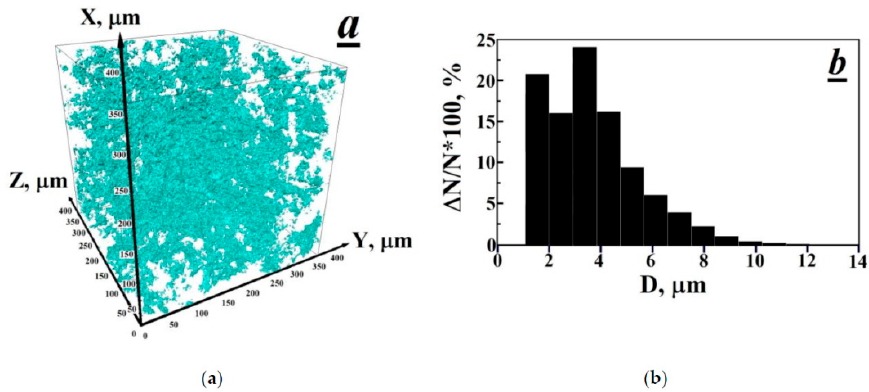
Figure 1. Three-dimensional image X-ray computed microtomography of a porous structure in the volume of a polytetrafluoroethylene sample ( a ) and the histogram of the size distribution of pores ( b ).